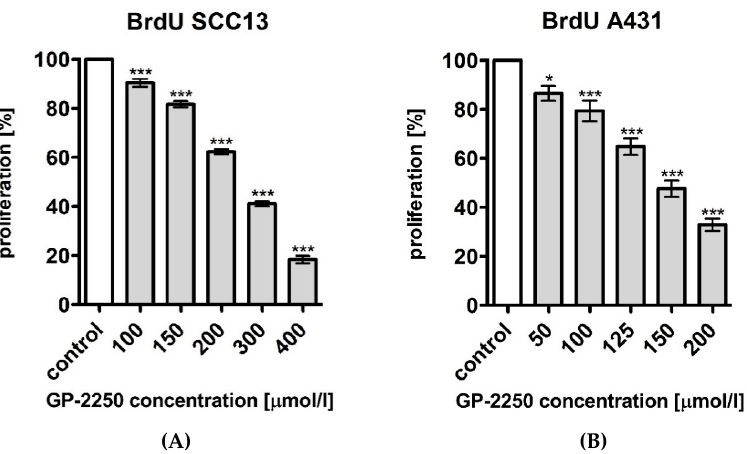
Figure 3. Effects of Substance GP-2250 in different cSCC cell lines, measured by BrdU assay. ( A ) SCC13 cells were incubated with GP-2250 (100, 150, 200, 300 and 400 μ mol/L) for 6 h. ( B ) A431 cells were incubated with GP-2250 (50, 100, 125, 150 and 200 μ mol/L) for 6h. Values are expressed as mean value ± SD of three independent experiments. The asterisk symbols indicate significant dif- ferences between